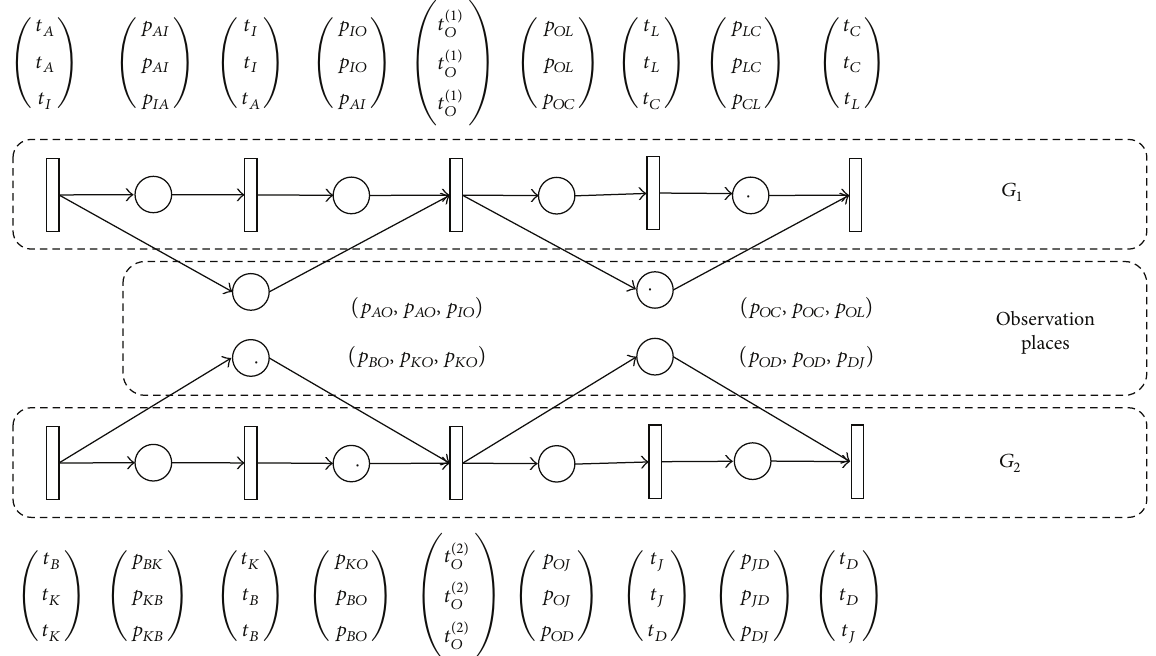
Figure 7: Constraint-free state transition model of types I, II, and III horizontal crossing protection zone.